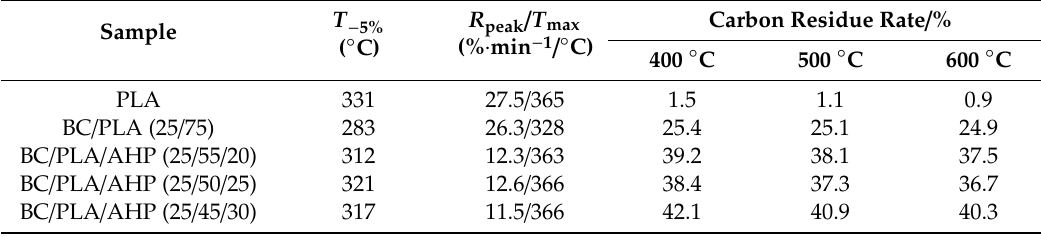
Table 4. TG test data of PLA, BC / PLA, and BC / PLA / AHP materials under N 2